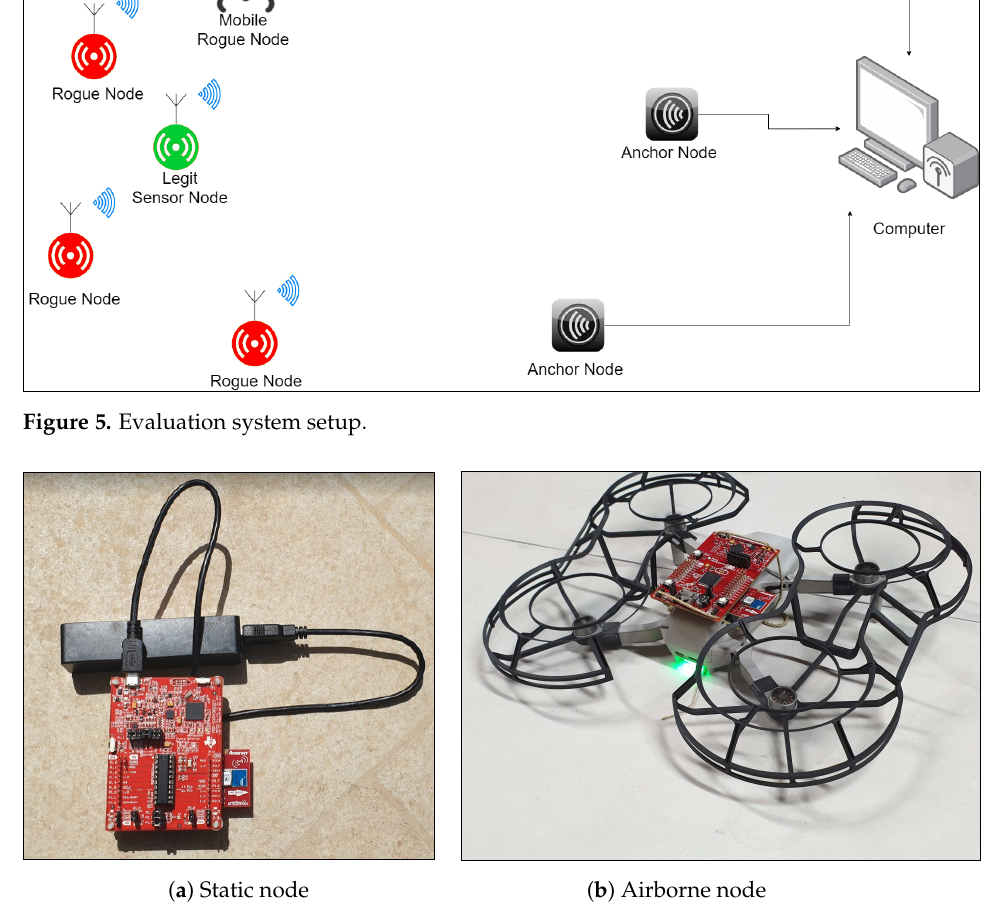
Figure 6. ( a ) MSP-EXP430G2ET, powered by an external battery pack. ( b ) MSP-EXP430FR5994, mounted on a Mavic Mini drone. Both use a CC110L RF